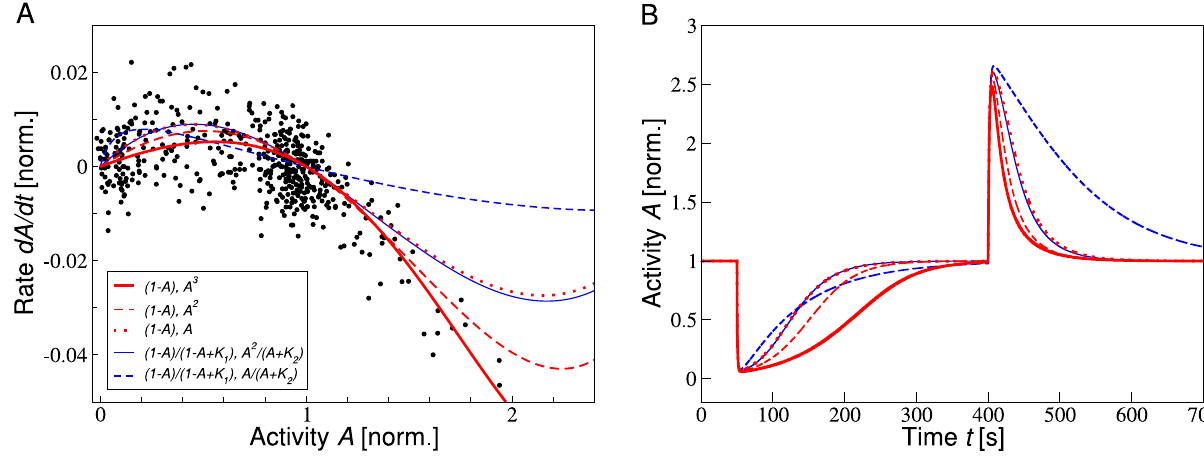
Figure 4. Comparison of different adaptation models. (A) Rate of activity change during adaptation as a function of activity for FRET data (WT1; symbols) and different adaptation models (colored lines). Experimental FRET activity change is measured at ambient concentration c 0 ~ 0 : 1mM for added and subsequently removed concentration step changes D c =0.03, 0.05, 0.1, 0.4 and 2 mM. For the five models, the dependencies of the methylation and demethylation rates on the receptor complex activity A are given in the legend and are explained in the text. Models were fitted to the experimental dA = dt data using a least-squares fit, where the methylation rate constant g R was the only fitting parameter. The demethylation rate g B was determined to produce the adapted activity A (cid:2) & 1 = 3 . The parameters K 1 and K 2 were converted from [17]. (B) Representative time courses for the different models in panel A for a concentration step change D c ~ 0 : 1mM at ambient concentration c 0 ~ 0 : 1mM . FRET and receptor complex activities, as well as activity rate changes were normalized by adapted pre-stimulus activities at ambient concentrations before addition of MeAsp. Least-squares errors between experimental data and model in panel A are 0.0021 [ 1 { A , A 3 ], 0.0022 [ 1 { A , A 2 ], 0.0025 [ 1 { A , A ],